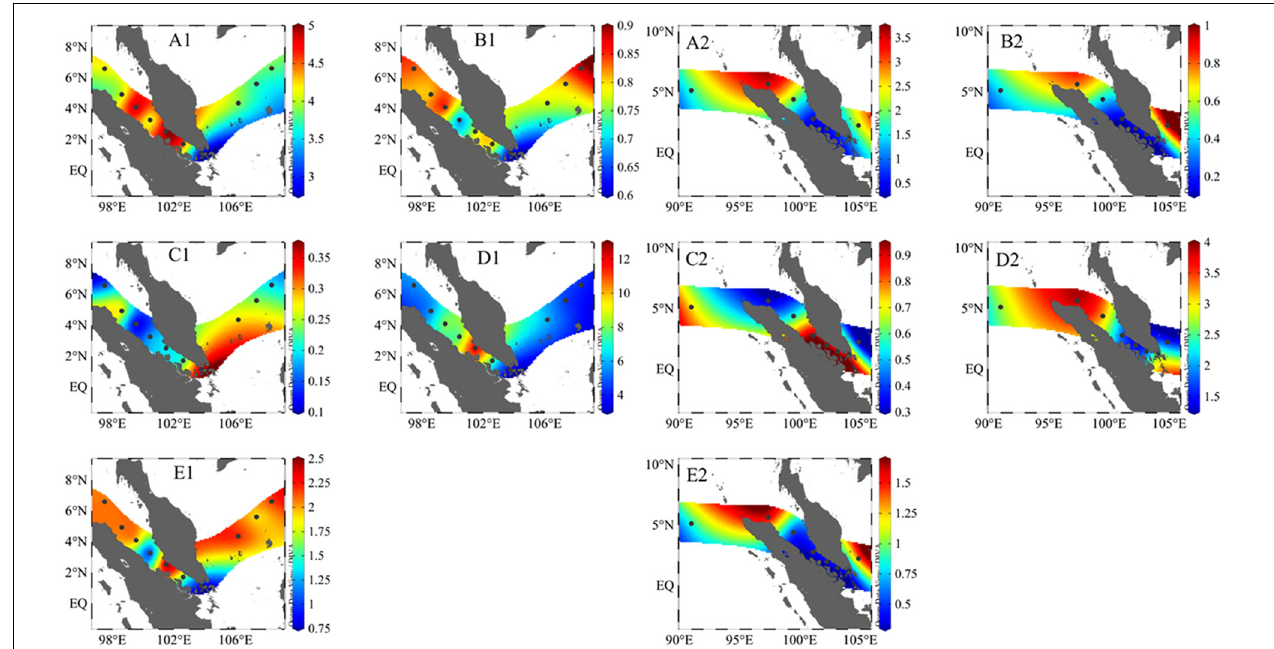
FIGURE 5 | The distribution pattern of phytoplankton biodiversity indices in 2017 cruise (A1–E1) and 2018 cruise (A2–E2) . Panels (A–E) Shannon–Wiener ( H (cid:48) ), Shannon evenness ( J ), Margalef (Dmg), Menhinick ( D M ), and Simpson index ( D ).